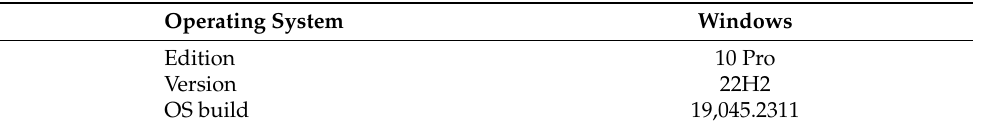
Table A4. Operating